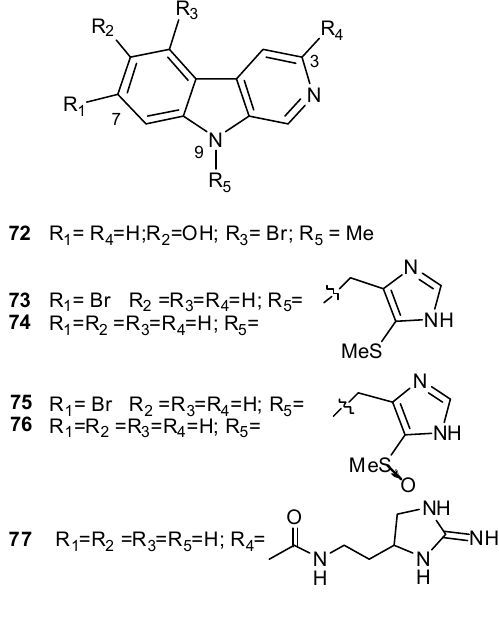
Figure 7. Structures of shishijimicin A ( 78